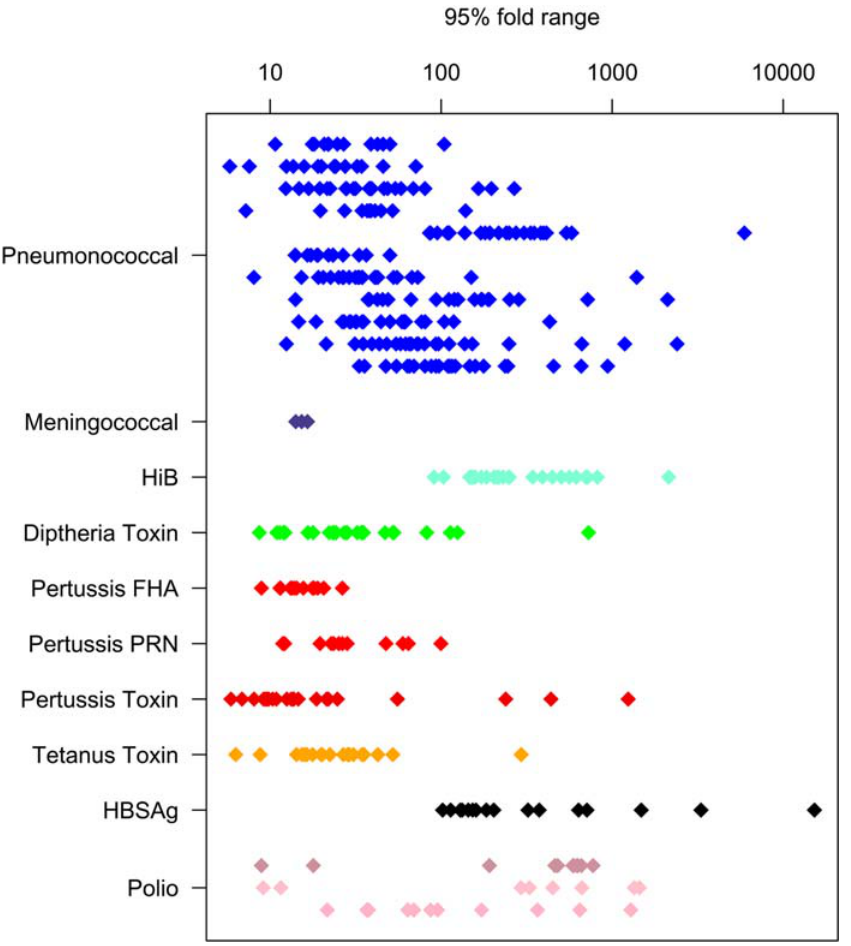
Figure 1. The fold range of the immune response reported for 396 immunogens in vaccine trials in infants. Each point is the ratio of the estimated 97.5 th percentile antibody response to the 2.5 th percentile response (i.e. the 95% range) in the post vaccination sera. Most vaccine trials contained several immunogens. Eleven serospecificites are reported for pneumonococcal vaccines. The order from top to bottom is serotypes 1, 3, 4, 5, 6B, 7F, 9V, 14, 18C, 19F and 23 F. The four meningococcal vaccine results are from the only infant trial in this data base and are a single determination of each of the A, C, W173 and Y specificities. Polio values are ranges for neutralizing activity for Polio 1, 2 and 3, respectively, from left to right. References to the individual trials are contained in supplementary file Database